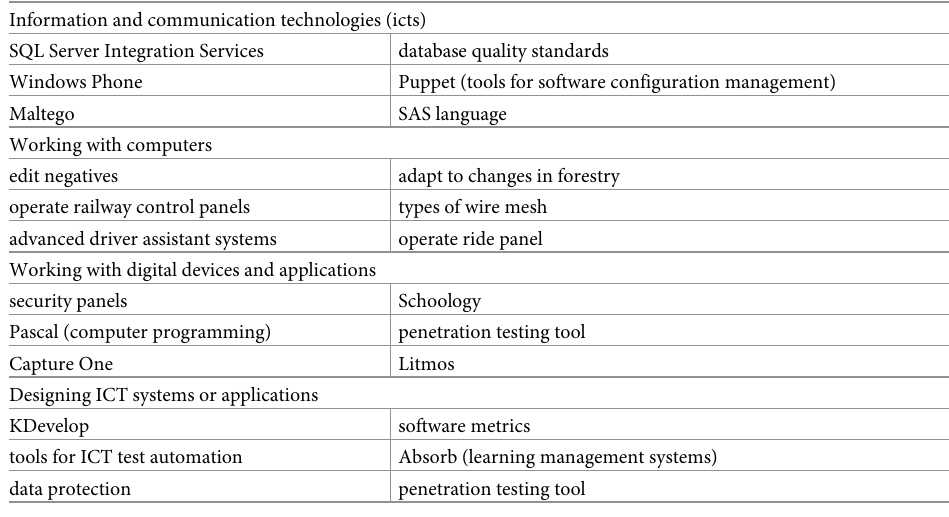
Table 2. Examples of digital skills by digital skill groups.